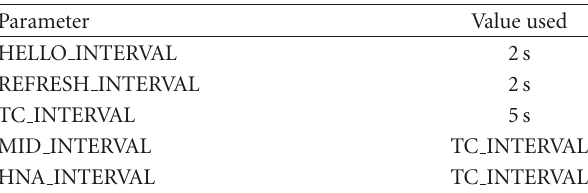
Figure 16: Result comparison of Castadiva with ns-2 without rout- ing. Table 2: Default OLSR parameter